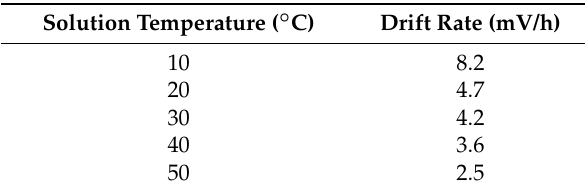
Table 5. The drift rates of the arrayed flexible RuO 2 /GO chloride sensor in the 1 M NaCl solution from 10 to 50 ◦